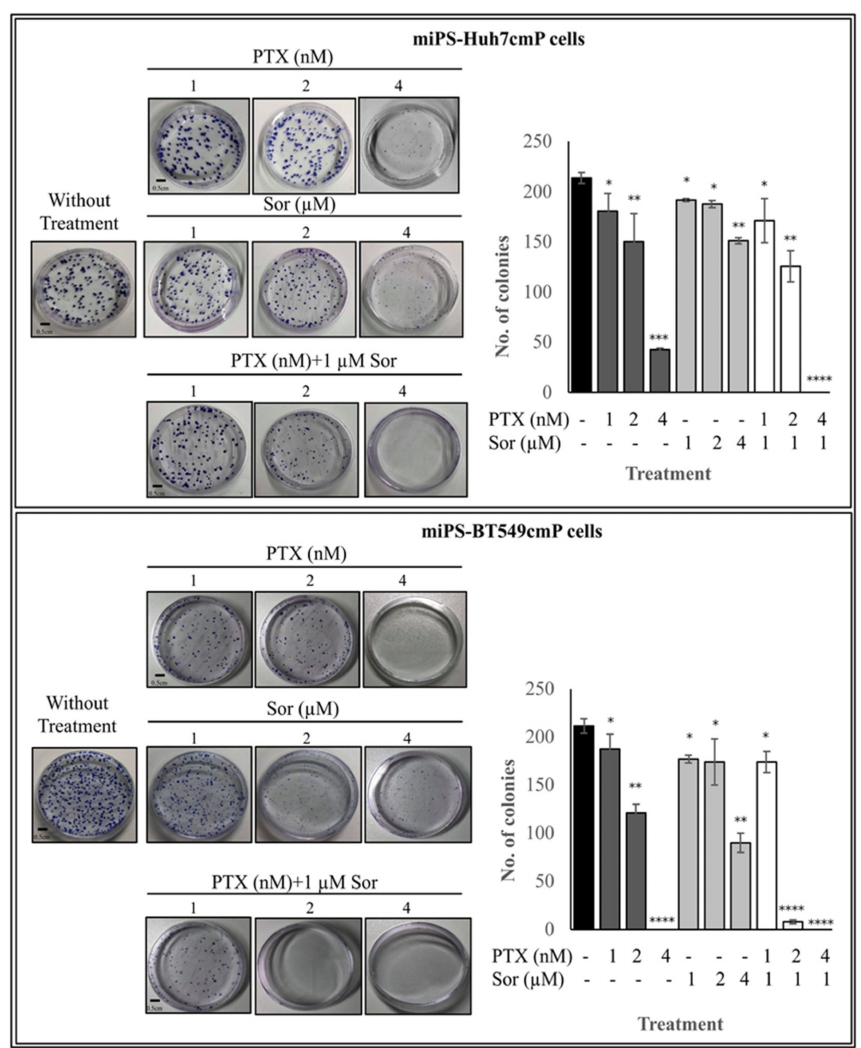
Figure 5. Co-treatment of PTX and Sor a ff ect colony formation potential better than monotherapy. The e ff ect was measured by clonogenic assay using Giemsa stain and colonies with a diameter ≥ 50 µ m were counted. Combined treatment inhibited viability in both cell lines in a dose- and time-dependent manner. All experiments were performed in triplicate and data are presented as the mean ± SD of three separate experiments (* p < 0.05; ** p < 0.001; *** p < 0.0001, **** p < 0.00001 vs. the control